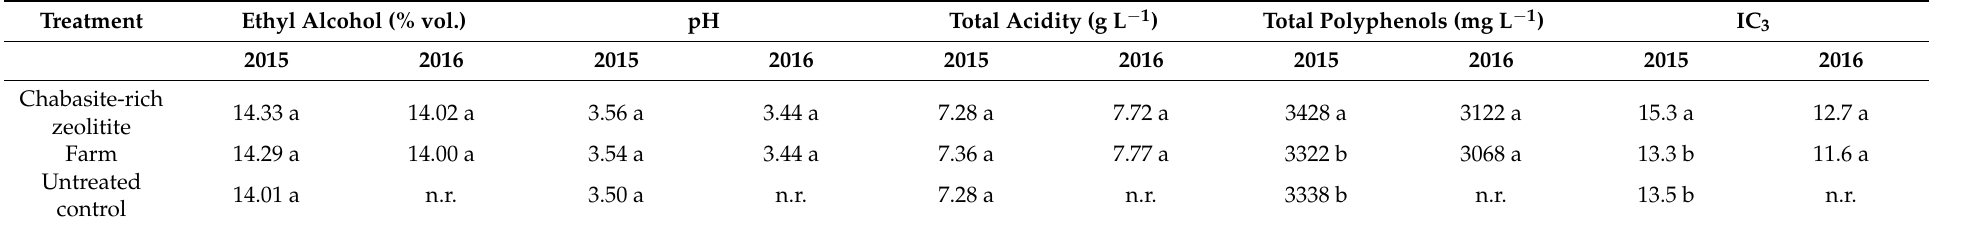
Table 6. Mean composition parameters for Montepulciano wines of the Ari vineyard treated with Italian copper chabasite-rich zeolitite and farm products, recorded in 2015 and 2016, after 3 months of